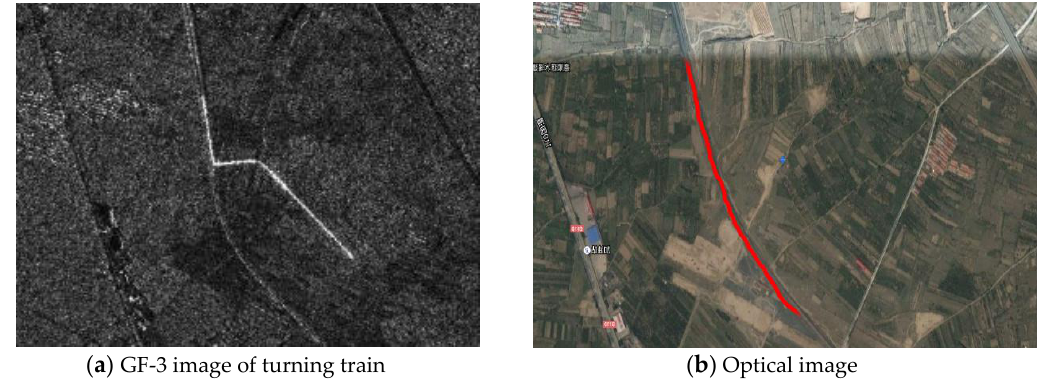
Figure 5. GF-3 SAR image and its corresponding optical image.